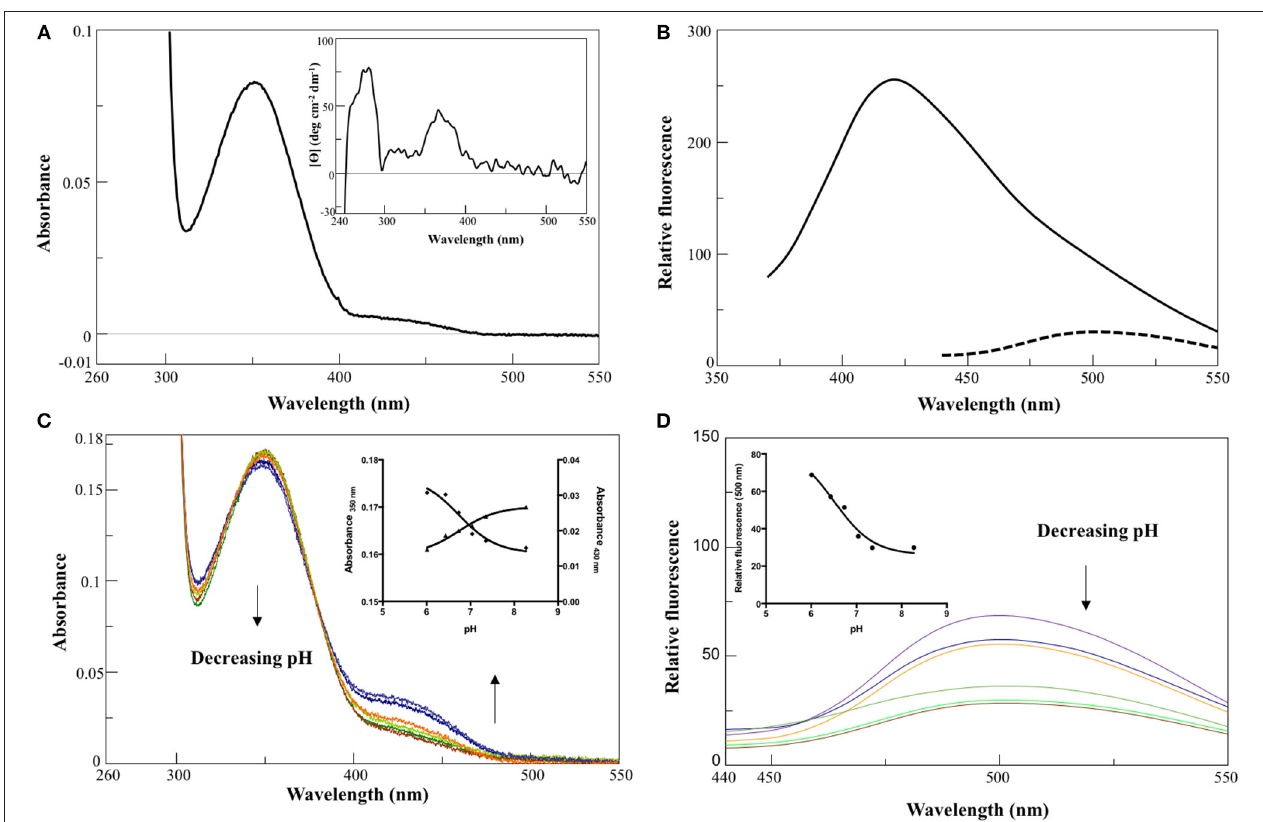
FIGURE 2 | Spectroscopic features of holoAroH . ( A) Absorbance and CD (inset) spectrum of 8 µ M holoAroH in 0.1M KP, pH 7.4. (B) Internal aldimine emission fluorescence of 1 µ M holoAroH upon excitation at 350nm (—) and 432nm (- -). (C,D) pH-dependence of the visible absorbance spectrum of holoAroH (10 µ M) and of the internal aldimine emission fluorescence at 500nm (exc. at 432nm; 1 µ M enzyme concentration) in KP 0.1M at pH 6.02, 6.43, 6.75, 7.03, 7.44, and 8.31. The insets of both panels show the fitting of data to obtain the pK spec